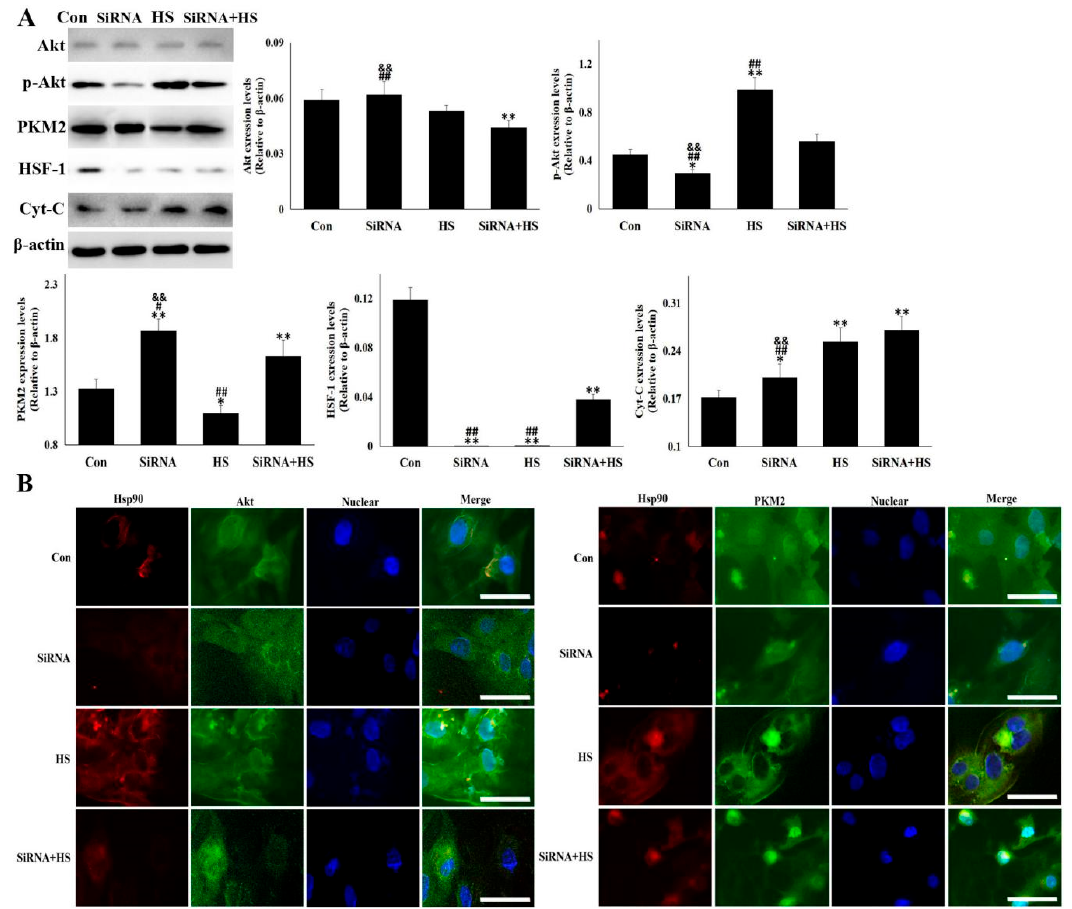
Figure 4. Akt and PKM2 were regulated differently by Hsp90. Western blot analysis and immunocytochemistry were performed with the indicated antibodies. Data represent the means ± SD for three independent experiments. ( A ) CMVECs were treated with or without SiRNA followed by heat stress of 5 h or not. Total proteins were used for semi-quantitative detection of the corresponding protein. The relative abundance of the tested proteins was normalized to that of β -actin. ( B ) CMVECs were treated with or without SiRNA followed by heat stress for 5 h or not. Immunofluorescence was performed using anti-Hsp90, anti-Akt and anti-PKM2 antibodies. Representative images were presented from Con, SiRNA, HS, and SiRNA + HS (Hsp90: red fluorescence, Akt/PKM2: green fluorescence, nucleus: blue fluorescence, the merged signals of Hsp90 with Akt/PKM2 in the cytoplasm: yellow fluorescence). Bar = 20 µm. Con, cells without SiRNA transfection and heat stress; SiRNA, cells transfected with SiRNA; HS, heat-stressed cells without SiRNA transfection; SiRNA + HS, heat-stressed cells following SiRNA transfection. The differences of the data of cells with different treatment vs. that of the Con are indicated by * p < 0.05 and ** p < 0.01. The differences of the data of cells treated by SiRNA+HS vs. that in SiRNA or HS are indicated by # p < 0.05 and ## p < 0.01. The difference of the data of cells treated by SiRNA vs. that in HS is indicated by & p < 0.05 and && p < 0.01.